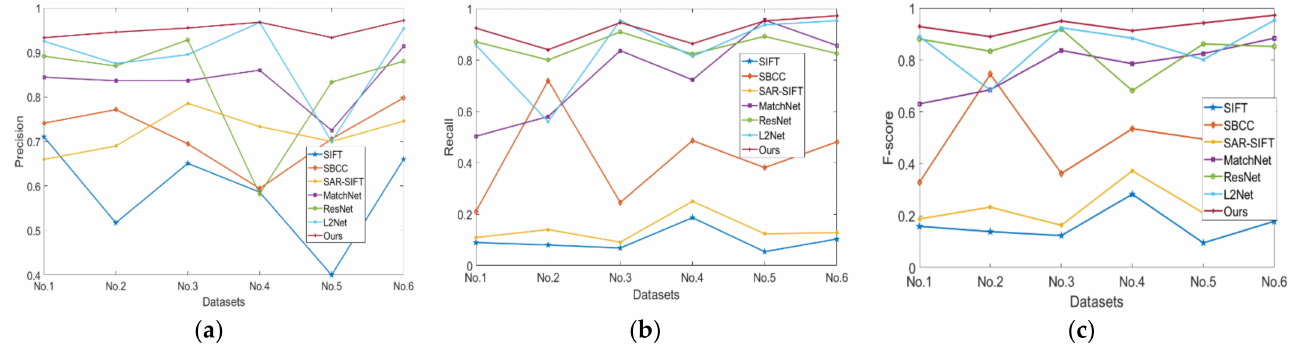
Figure 9. Performance of six sets of data with different polarization modes. ( a ) Precision. ( b ) Recall. ( c )